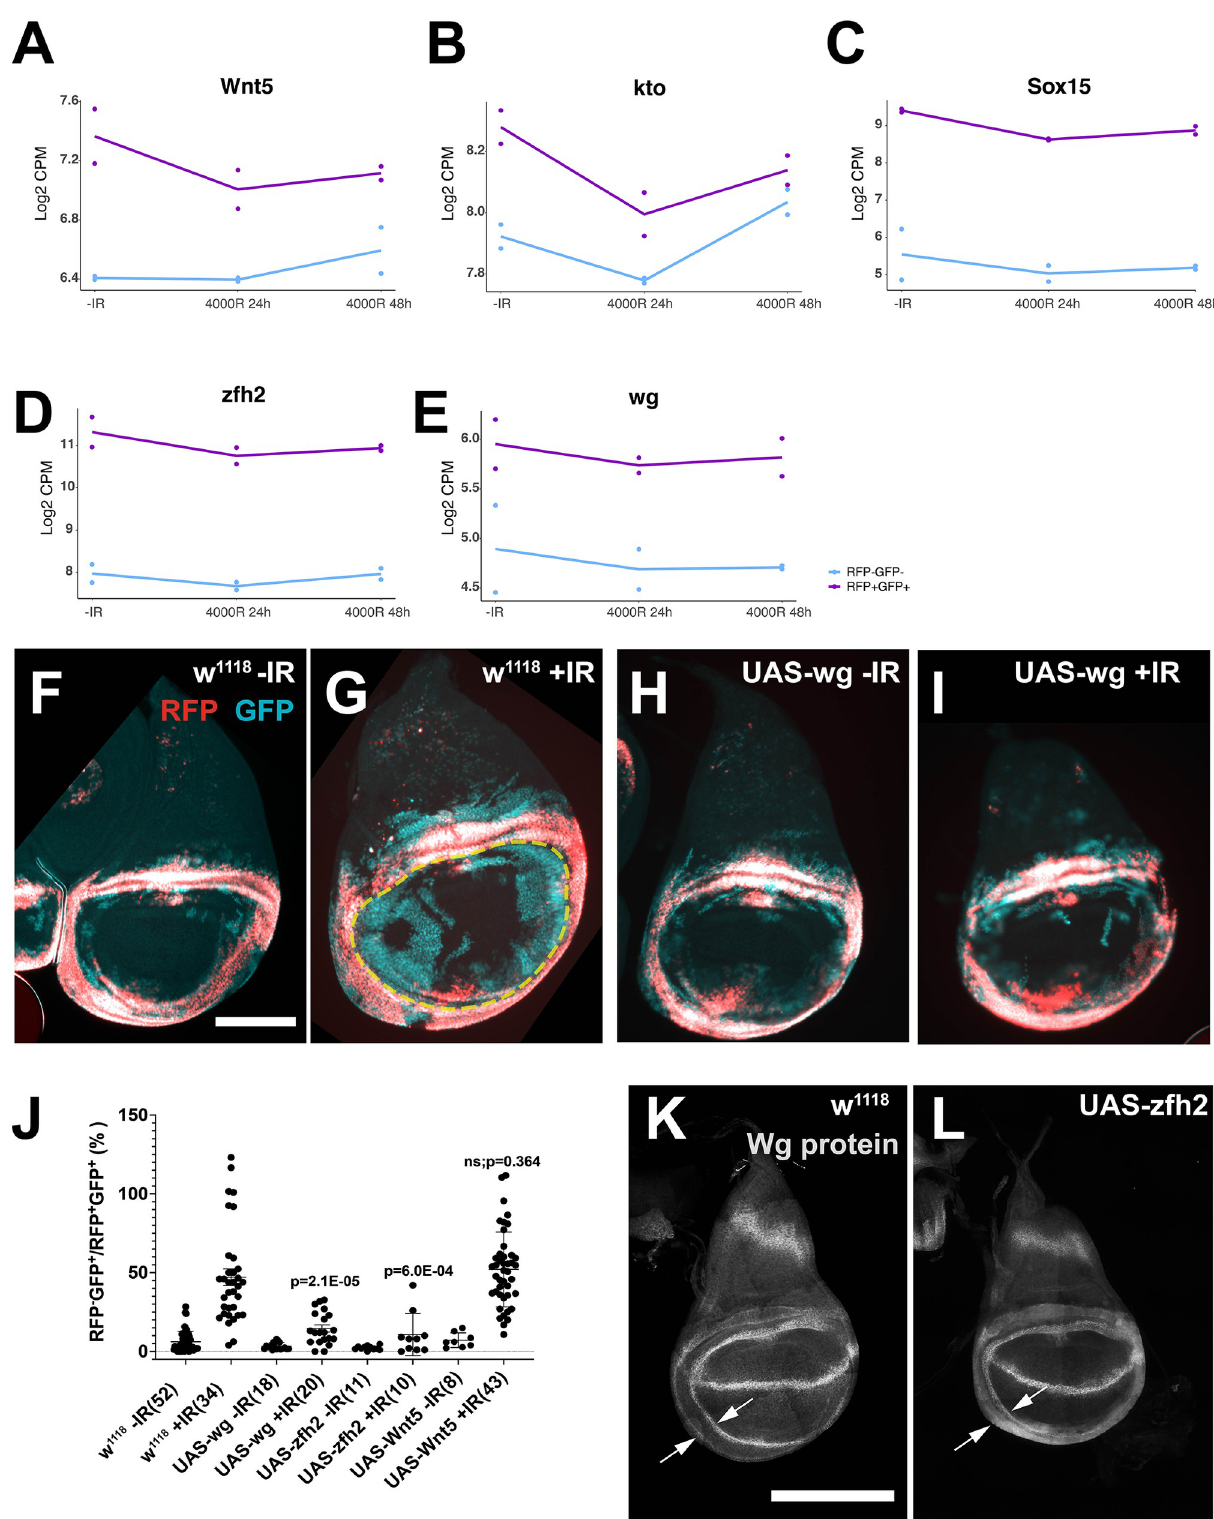
Fig 4. Elevated levels of Wg or Zfh2 inhibit the regenerative behavior of hinge cells. (A-E) Expression trajectories of five genes from the ORA groups on tissue development and specification. Pairs of dots represent data from two biological replicates. Lines connect the averages. (F-I) Wing discs